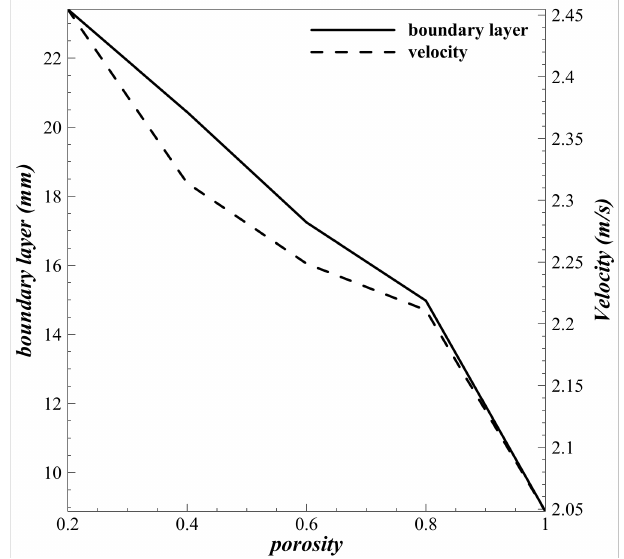
Figure 7. The variation in the velocity and maximum thickness of the boundary layer versus the porosity for a permeability of 5 × 10 − 6 m 2 , with u in = 2 m/s.